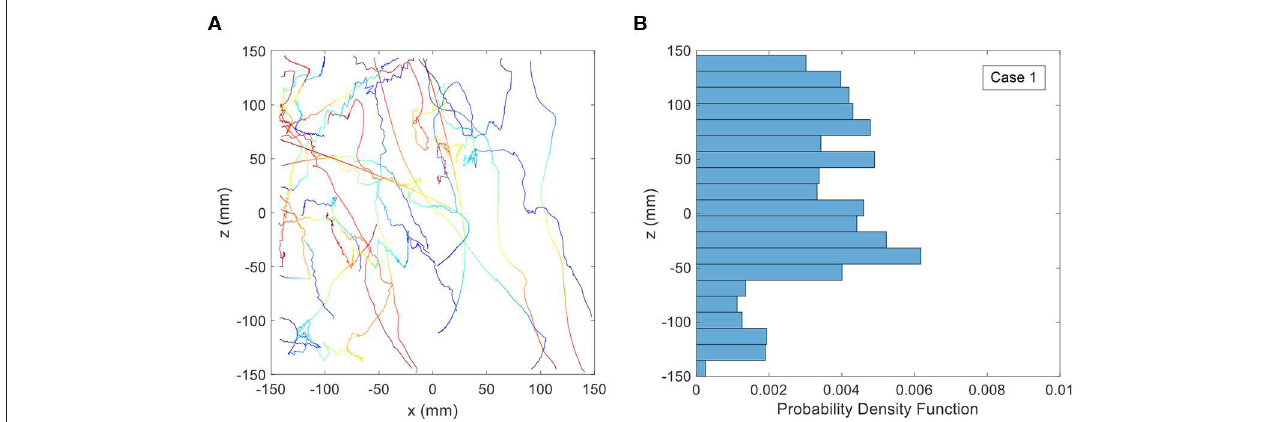
FIGURE 6 | (A) Copepod trajectories for the control treatment with stagnant, uniform density fluid. Color indicates the passage of time with blue corresponding to the beginning of the trajectory and red corresponding to the end. Although shown on the same plot, these trajectories were not collected simultaneously. (B) Probability Distribution Function (PDF) of copepod position in the vertical direction for the control treatment.